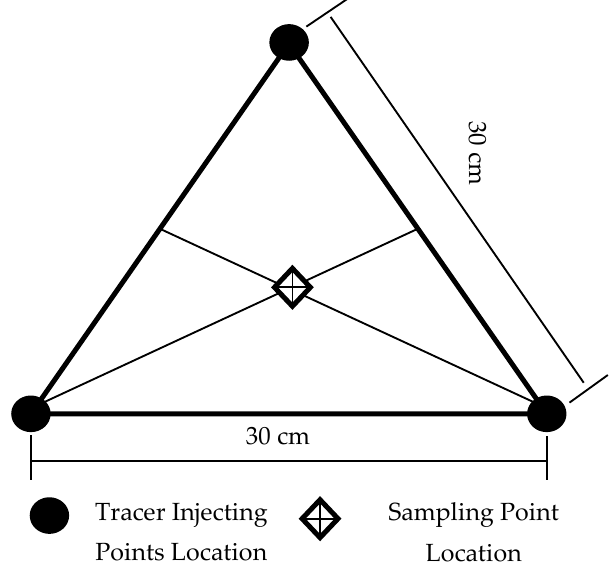
Figure 3. Schematic figure of sampling and tracer injecting points location.